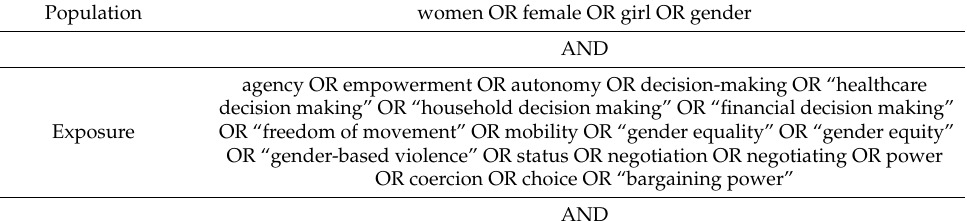
Table 2. Search strategy using Boolean